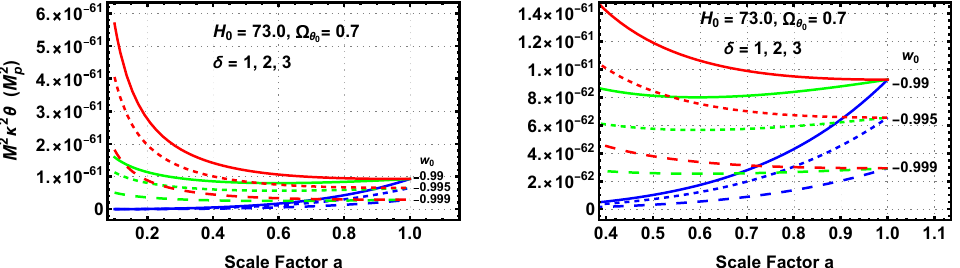
Figure 9. The ( left ) panel shows the evolution of M 2 κ 2 ˙ θ for all cases and the ( right ) panel shows the evolution at scale factors between 0.4 and 1.0 in more detail. The units of ˙ θ are m 2 , since θ has the units of mass and time has units of inverse mass. p In Figure 9, κ 2 ˙ θ is multiplied by M 2 to show the value of the time derivative of the true scalar ˙ φ . In the left panel, the full evolution of ˙ θ is shown for the scale factors between 0.1 and 1.0. Unlike the scalar, the magnitude of ˙ θ is decreasing for δ = 3 but increasing for δ = 1 with corresponding differences in the second derivative. The right hand panel shows the evolution between scale factors of 0.4 and 1.0 in more detail. Close inspection of the δ = 2 and w 0 = − 0.99 track show that it was initially decreasing but is currently increasing. This nonmonotonic evolution is also present in the dark energy EoS described later.